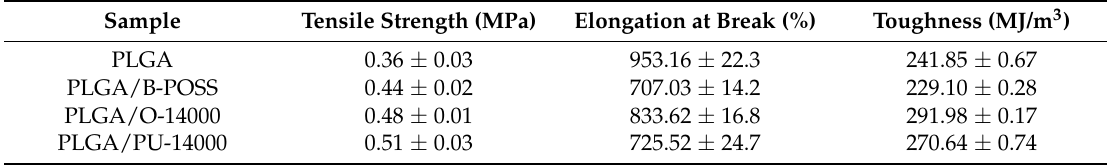
Table 3. Tensile strength and elongation at break of PLGA, PLGA/B-POSS, PLGA/O-14000 and